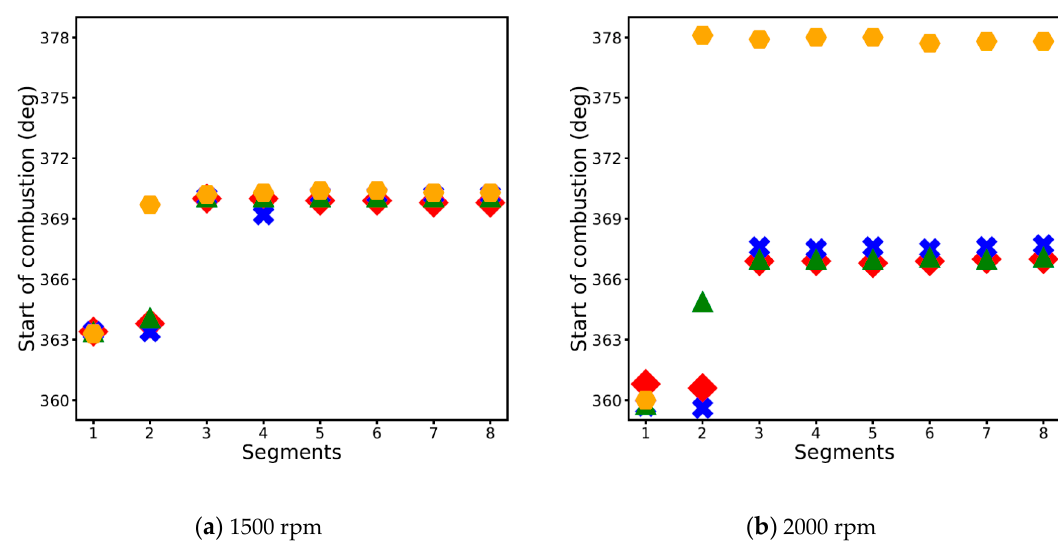
Figure 10. Start of combustion at all loads in each stage at ( a ) 1500 rpm and ( b ) 2000 rpm. The red thick diamond represents 100% load, the blue thick cross 50% load, the green triangle 75% load and the orange hexagon 25% load.